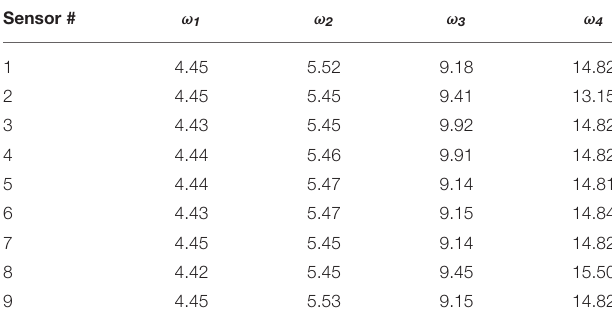
TABLE 3 | Frequencies (in Hz) identified from the different sensors. Sensor